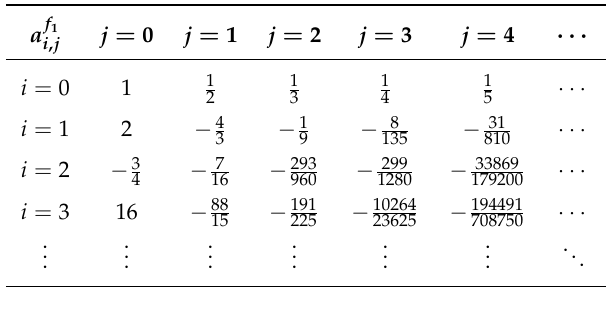
Table 1. The coefficients a f 1 of Thiele–Newton’s expansion of f 1 ( x , y ) given by Equation i , j